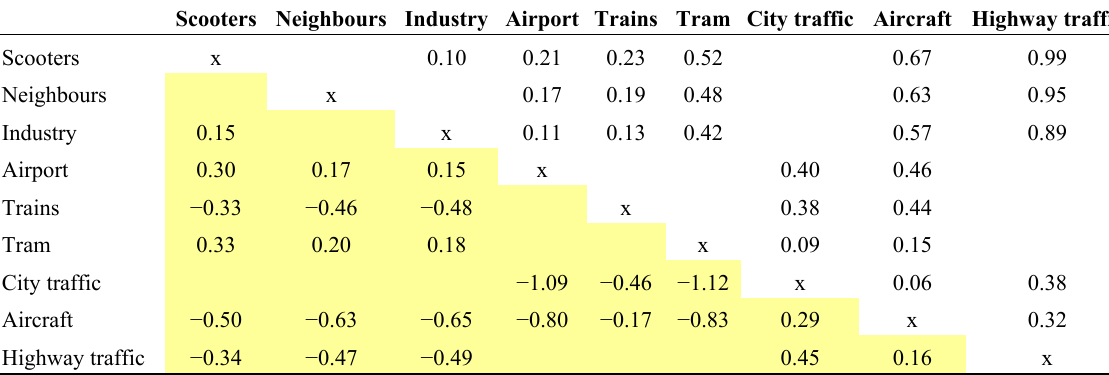
Table 4. Differences in average SD score per annoyance range between pairs of noise sources; differences are given when significant and separately in annoyance (4 ≤ A < 8, above diagonal) and high annoyance range (A ≥ 8; yellow below diagonal); SD scores of sources on top line are subtracted from sources in left column. x = diagonal of table.